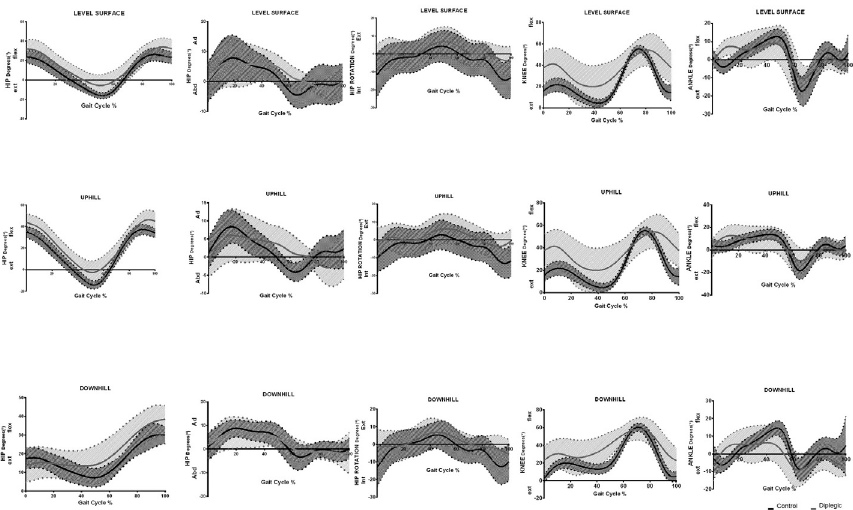
Figure 2 - Evolution of the angular variables of the hip, knee and ankle of the Control Group and Diplegic Group over time, in horizontal, ascent and descent